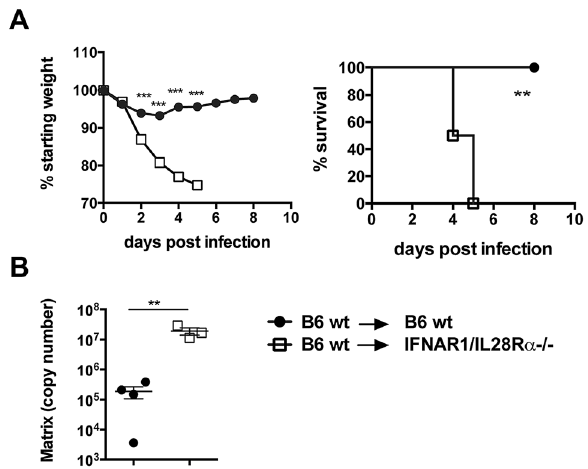
Figure 6. Lack of type I and III IFN signalling in the stromal compartment increases susceptibility to IAV infection. Chimeric mice were infected i.n. with 10 5 TCID 50 PR8, (A) Weight loss and mortality were measured. Graphs show mean 6 SEM and are representative of 2 independent experiments (n=6). (B) Viral replication was assessed by qRT-PCR on total lung RNA at 4 days post infection. *** p , 0.001, ** p , 0.01 by 2-way ANOVA with Bonferroni post tests (weight loss), Log-rank (Mantel-Cox) Test (survival) or unpaired t test